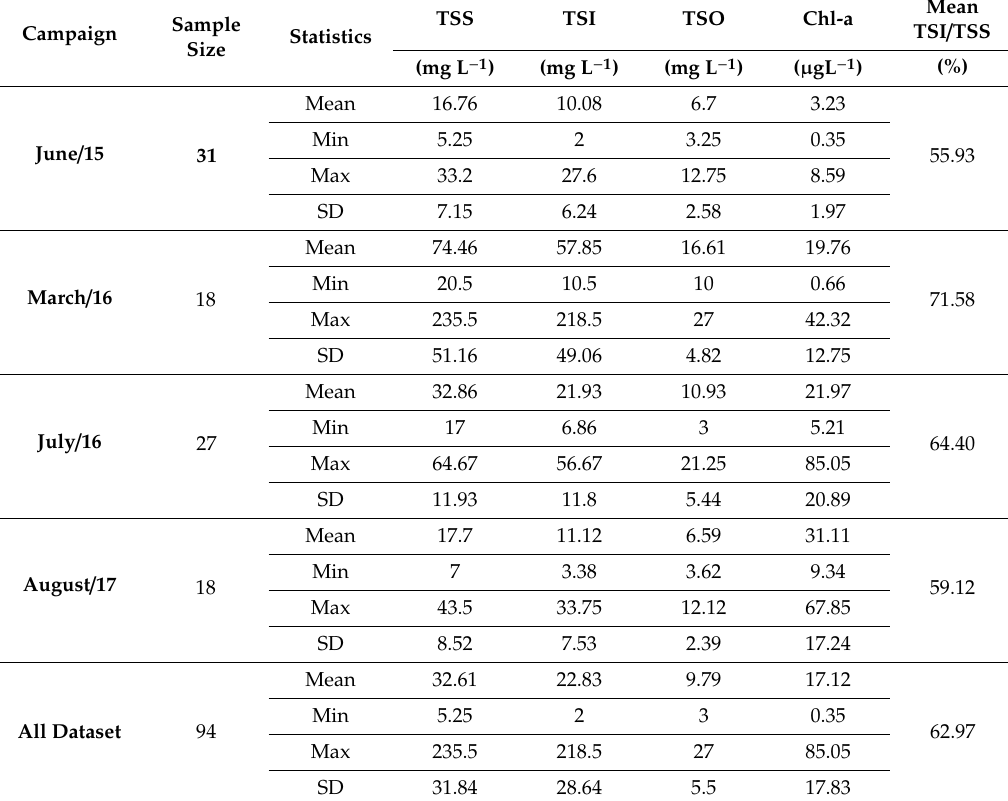
Table 2. The mean, minimum (Min), maximum (Max), and standard deviation (SD) values for TSS, TSI, Total Suspended Organic Solids (TSO), and Chl-a concentration and the mean TSI / TSS ratio for each